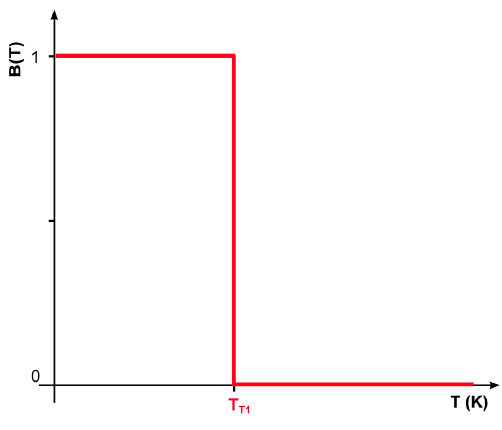
Figure A1. Function B ( T ).